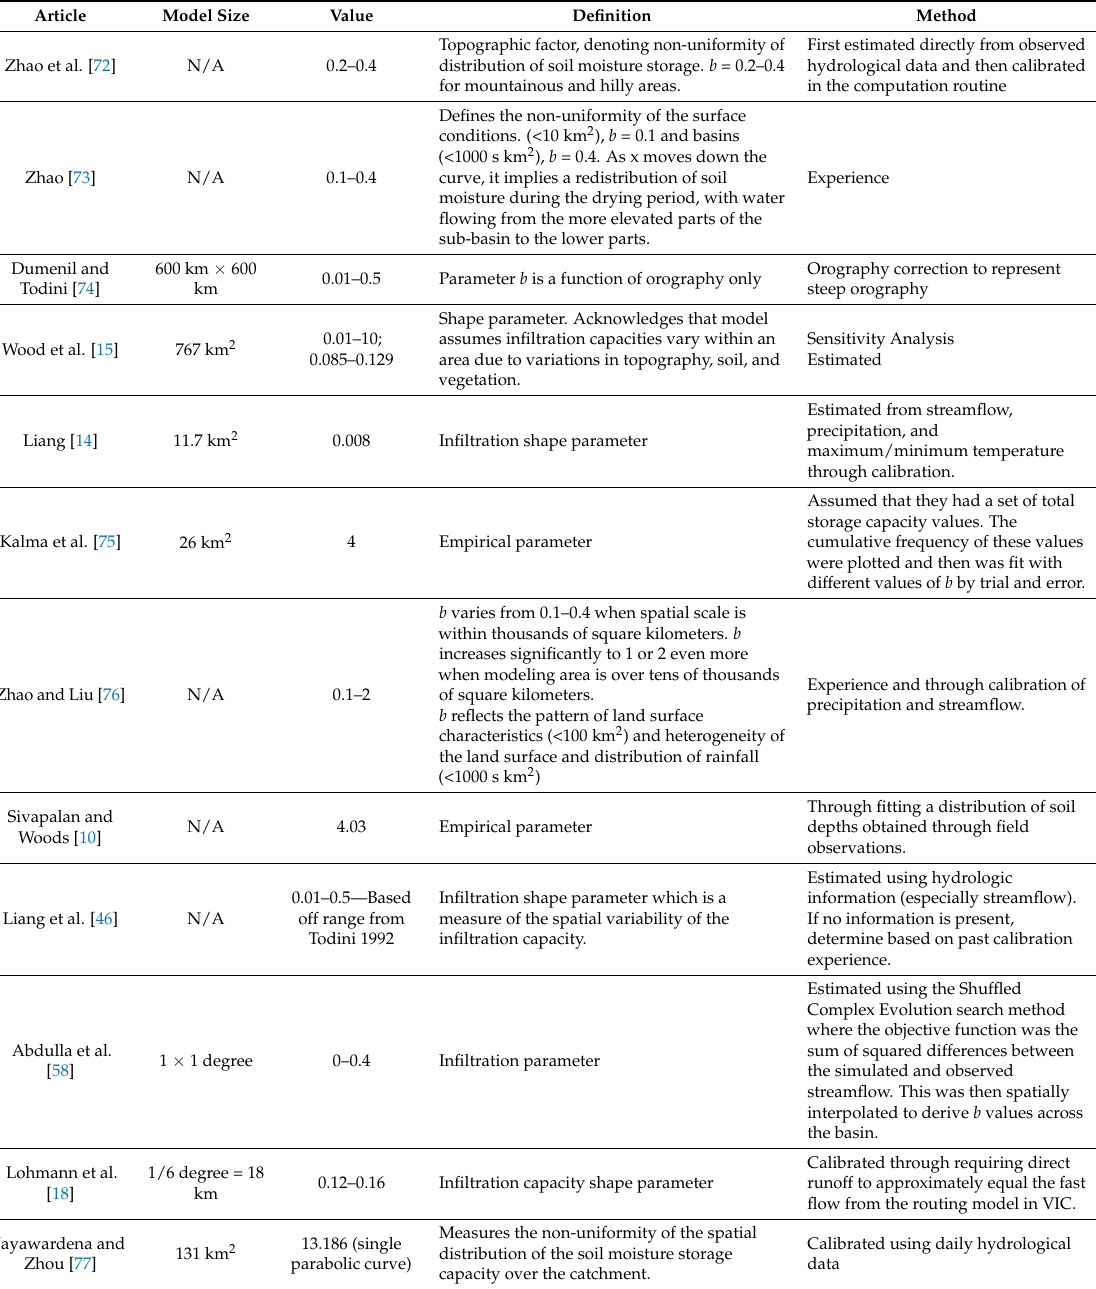
Table A1. Treatment of b parameter in various VIC